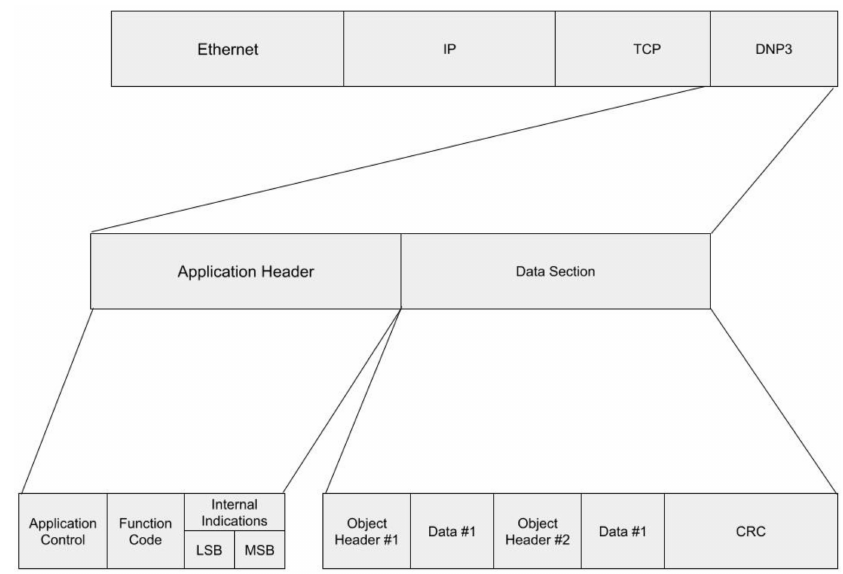
Figure 2. DNP3 application